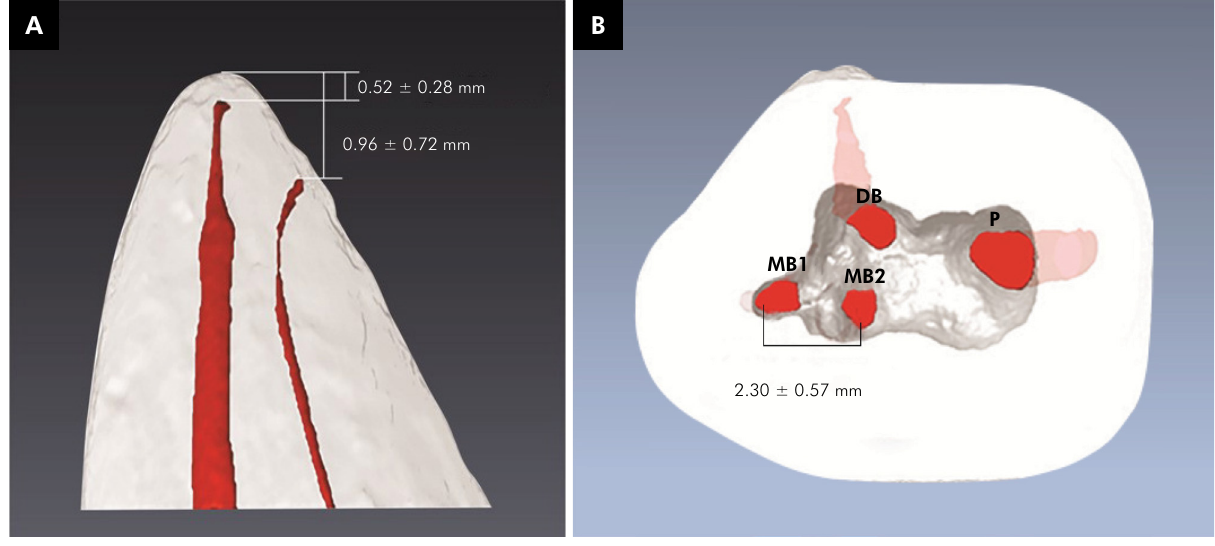
Figure 2. A. Reconstruction micro-CT images of the measurement between the foramen and apex of MB1 and MB2 canals. B. Distance between MB1 and MB2 canal orifices on the pulp floor.